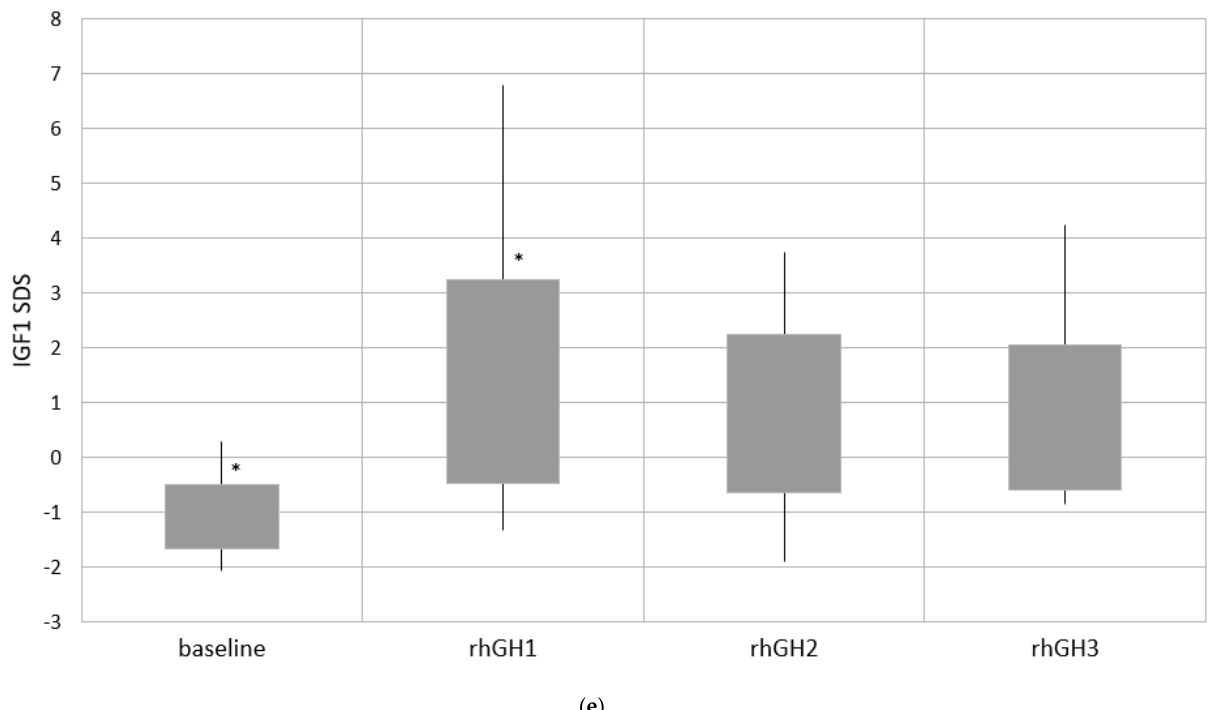
Figure 2. Insulin-like growth factor 1 (IGF1) SDS at baseline and during recombinant human growth hormone (rhGH) treat- ment. The bottom of the box indicates -1 SDS; the top of the box, +1 SDS; and the vertical lines, minimal and maximal values. * p < 0.05 for the mean values: rhGH1 vs. baseline, rhGH2 vs. rhGH1 and rhGH3 vs. rhGH2. ( a ) Whole cohort and ( b ) group 1: age ≤2 years of life; ( c ) group 2: age >2 an d ≤4.5 years of life; ( d ) group 3: age >4.5 and ≤8 years of life; and ( e ) group 4: age >8 years of life.